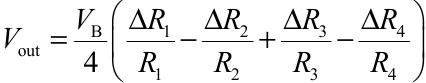
Figure 6. The piezoresistors on ( a ) R